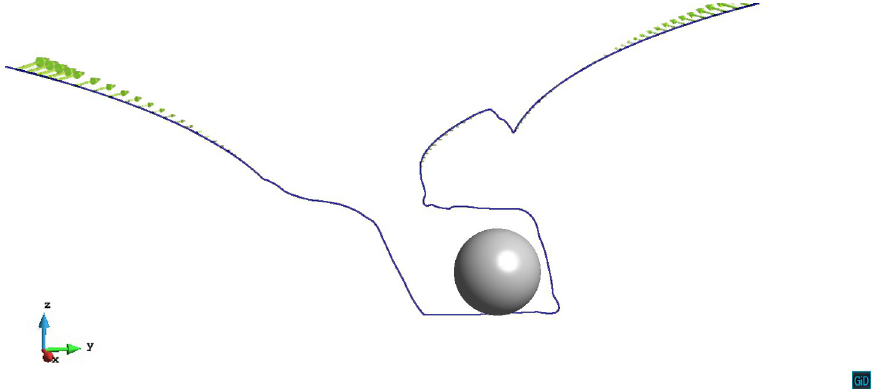
Figure 14. The dislocation topology and nodal velocity vectors in z / R = − 1.0 case. The plastic strain ε = 9.64 × 10 − 4